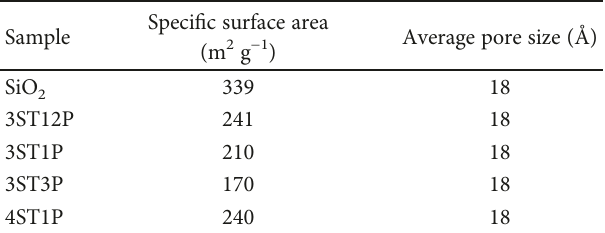
Table 4: Speci fi c surface area and average pore size of the synthesized